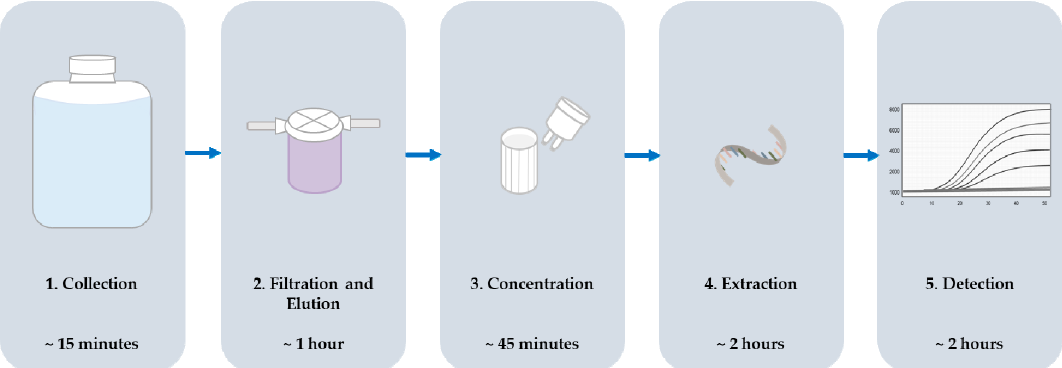
Figure 1. Sample processing scheme including order of steps and the time typically required to complete each step for one sample.